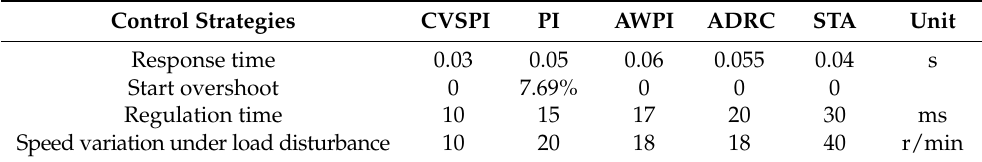
Table 4. Comparison of performance at 0.2 s with a sudden 15 N · m load at rated